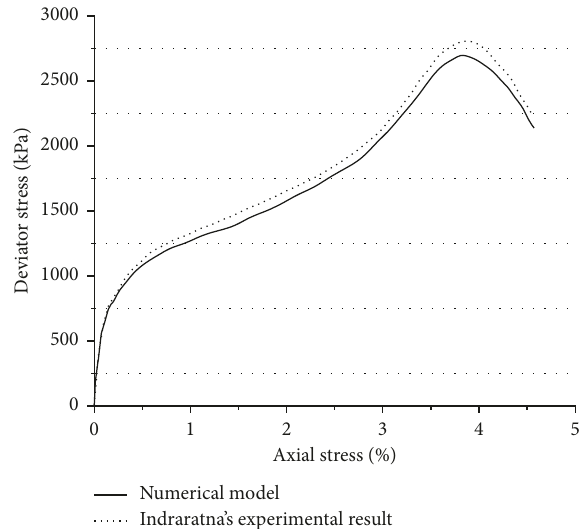
Figure 2: Comparison of the stress-strain curve obtained by the numerical model to that of Indraratna’s